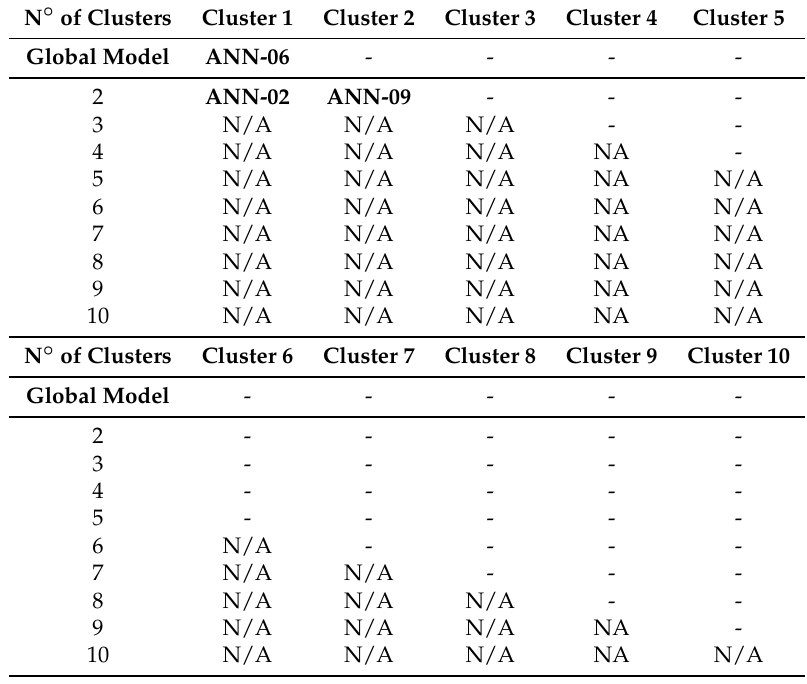
Table 3. Best regression technique for each cluster. ANN: Artificial Neural